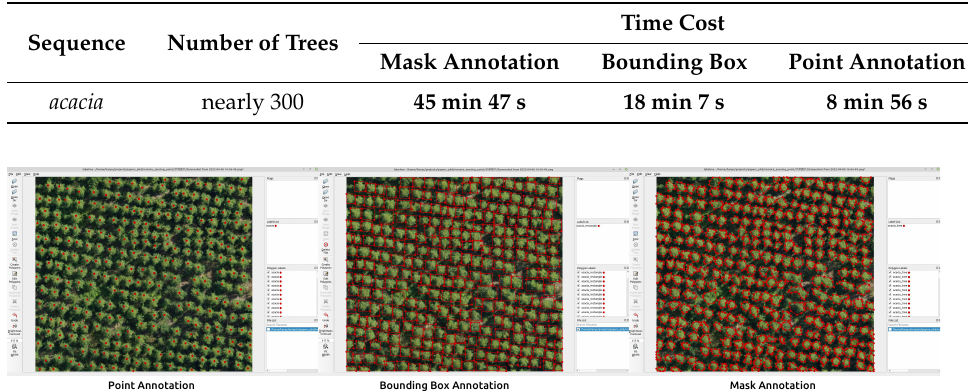
Figure 12. The annotation visualization with different annotation ways including point, bounding box, and mask annotation with the labelme